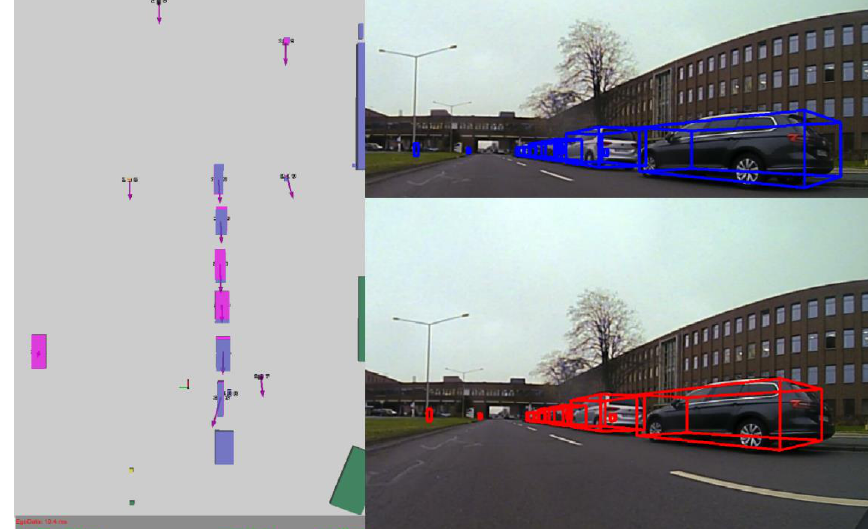
Figure 12. Tracking of static objects. In the left image, the 3D top-view scene containing measurements and tracks with their relative motion vectors is shown. In the top-right and bottom-right images, the measurements and tracks are projected onto the RGB image in blue and red, respectively. measurement over the tracked object is due to the ADTF viewer [50]. On the right-hand side, similar to Figure 11, we see the tracks in red color and the measurements in blue color projected onto the front image.